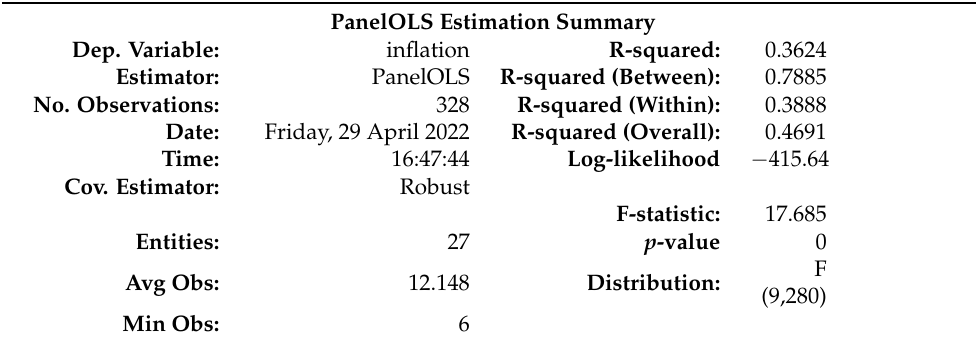
Table 5. The regression with added share of renewable electricity, real GDP growth and nominal effective exchange rate and their lags with past value of inflation